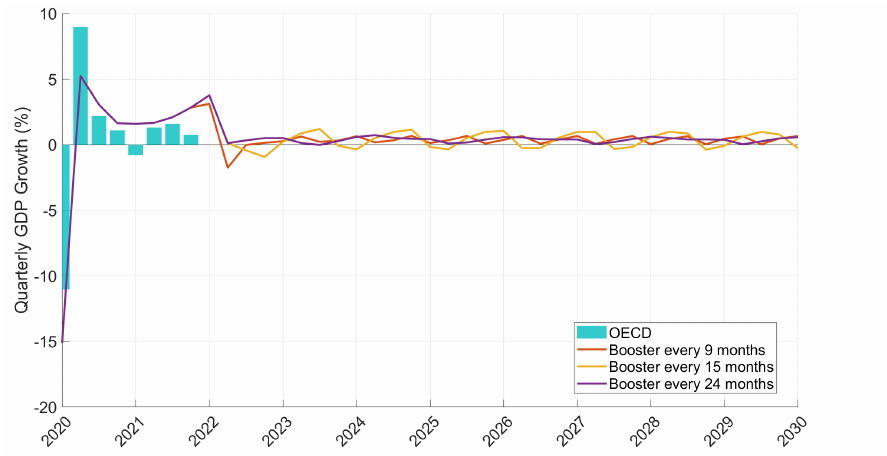
Figure 13. Prediction of percentage change in quarterly GDP considering periodic vaccination booster campaigns with periods of 270, 450, and 720